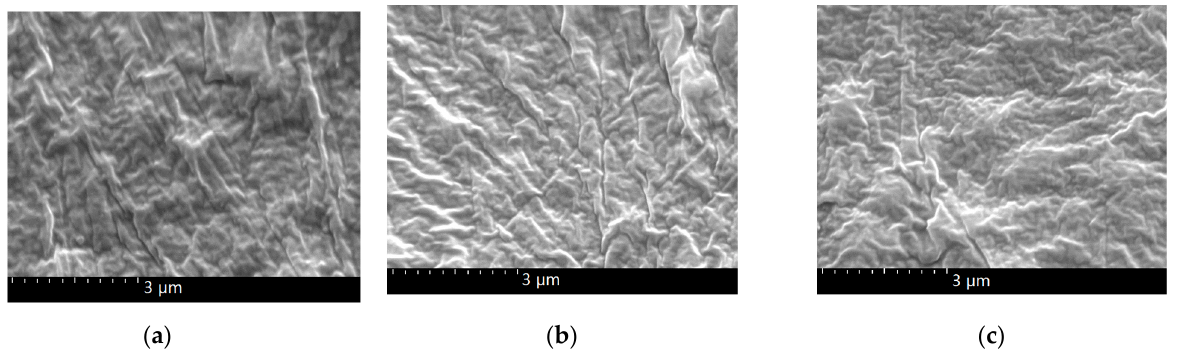
Figure 2. SEM of LDPE sections: ( a ) LDPE; ( b ) LDPE R-M; ( c ) LDPE H-M.